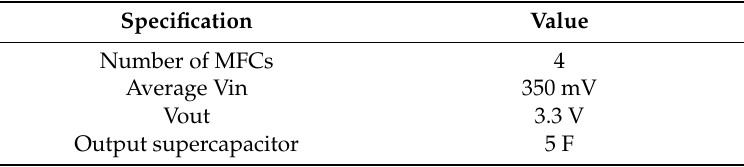
Table 2. Specifications of the MFC-powered Internet of Things (IoT)